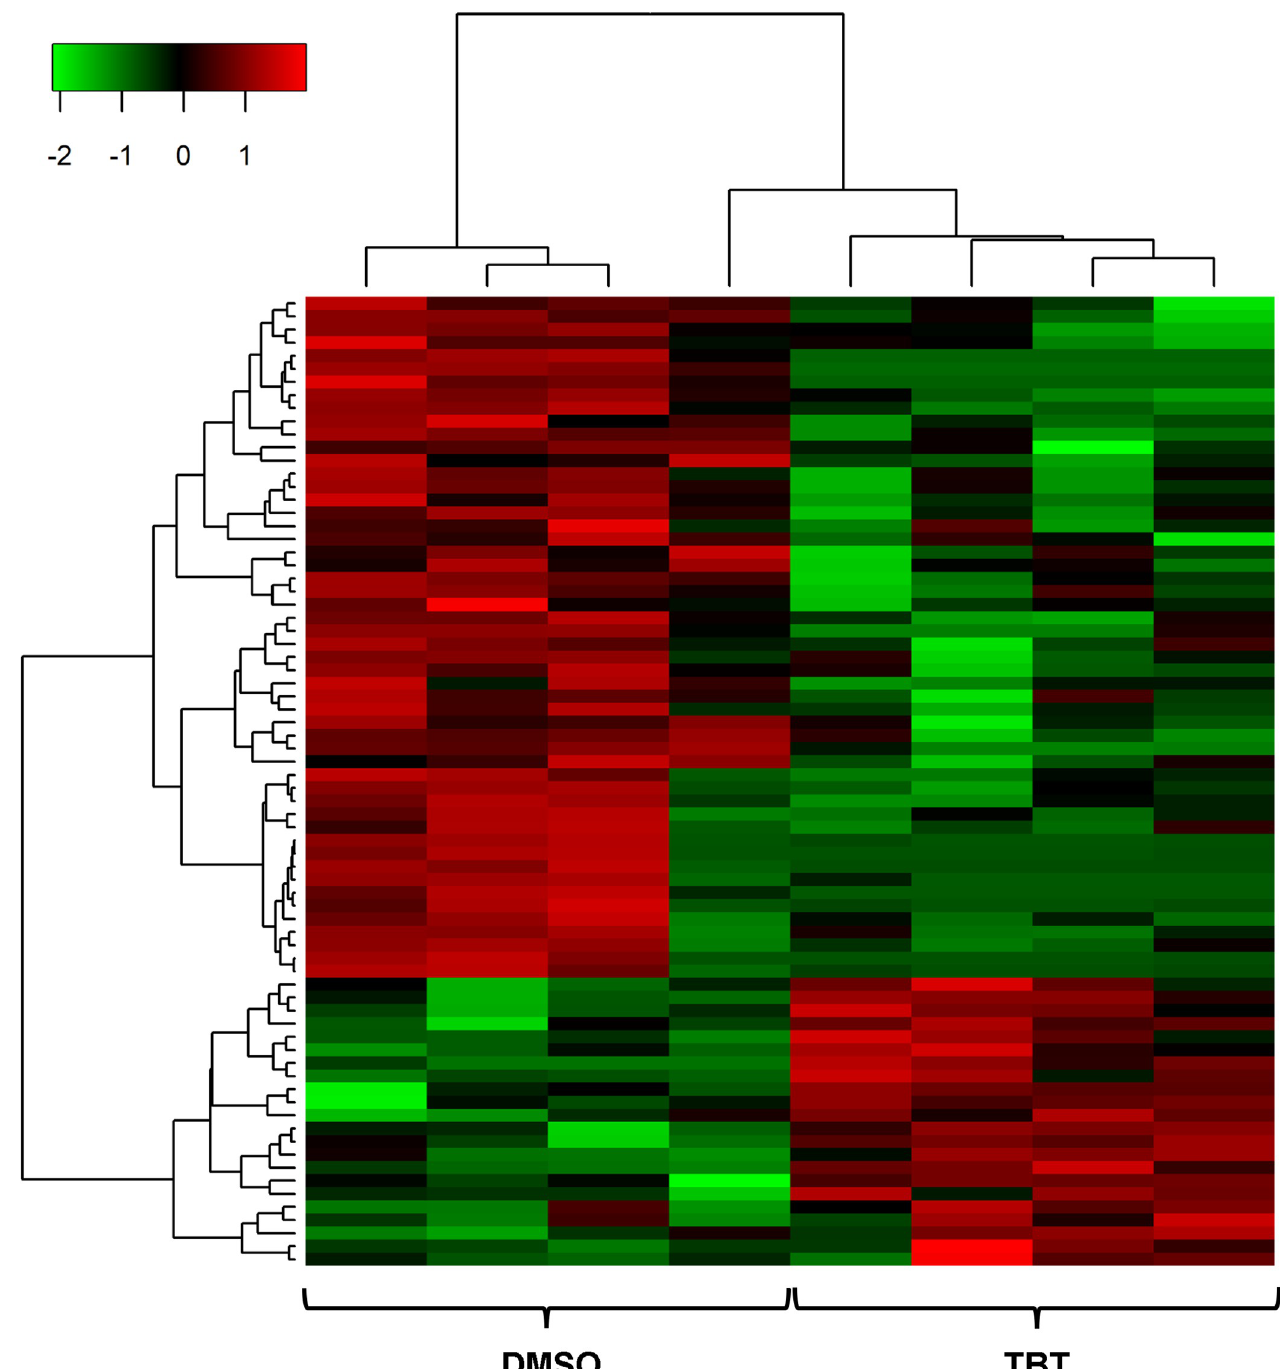
Fig 2. Heatmap of 74 differentially expressed lncRNAs between samples of gWAT ancestrally exposed to EDC TBT and samples of the control group (DMSO). Expression of lncRNA is represented according to the color scale shown at the top, corresponding to the z-score. Red represents higher expression, and green represents lower